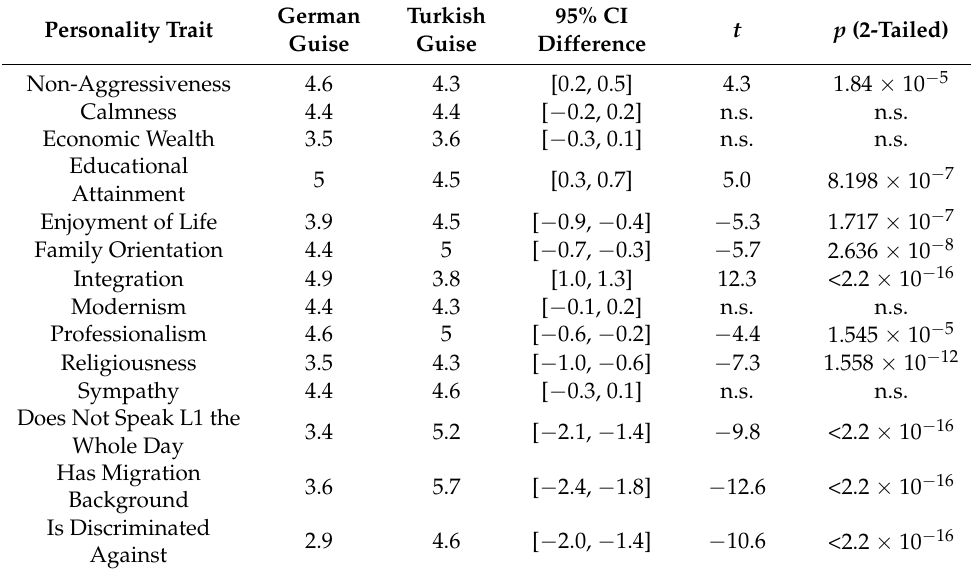
Table 4. Welch two-sample t -test by Language 1 .